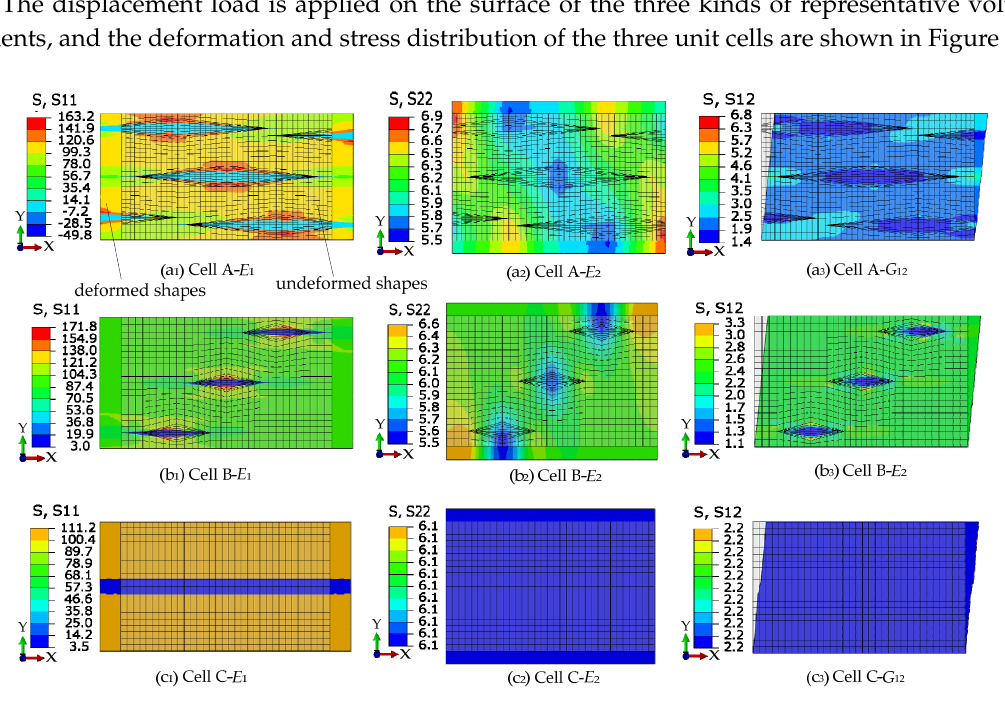
Figure 7. Deformed shape and contour plot of stress in different displacement loads.